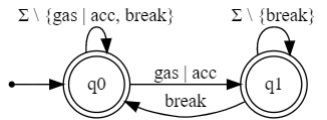
Figure 6. Cruise controller: Property P